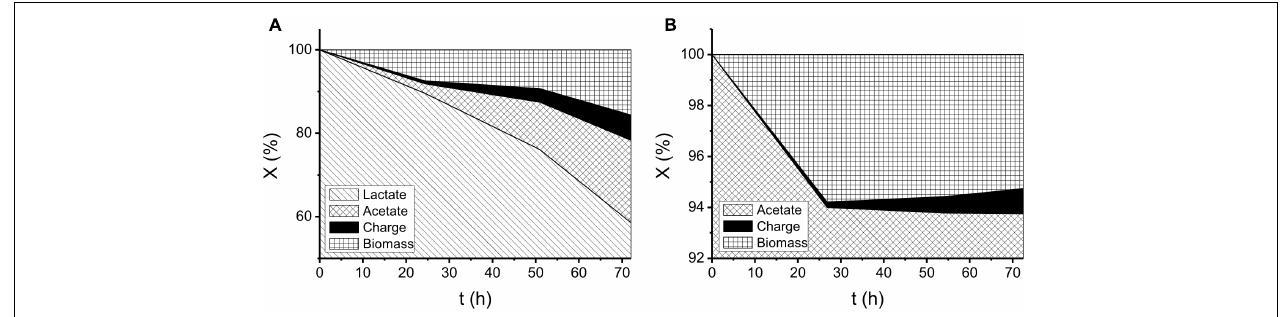
FIGURE 1 | Profiles of electron distribution illustrating organic-acid metabolism for 72 h in the electrochemical cells using ca. 35 mM of (A) lactate and (B) acetate as electron donors. X in the y axis denotes the electron quantities as fractions derived from the total charge in the initial-substrate mass (i.e., 12 Fn La and 8 Fn Ac in (A) and (B) ,